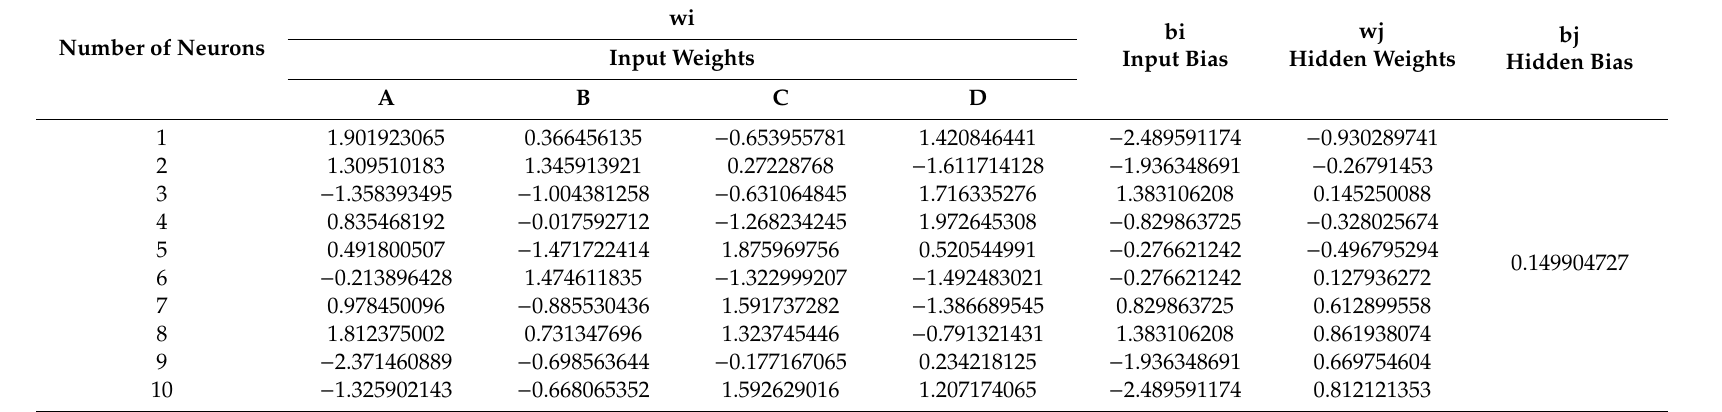
Table 5. The weights and biases of input layers (wi and bi) and hidden layers (wj and bj).